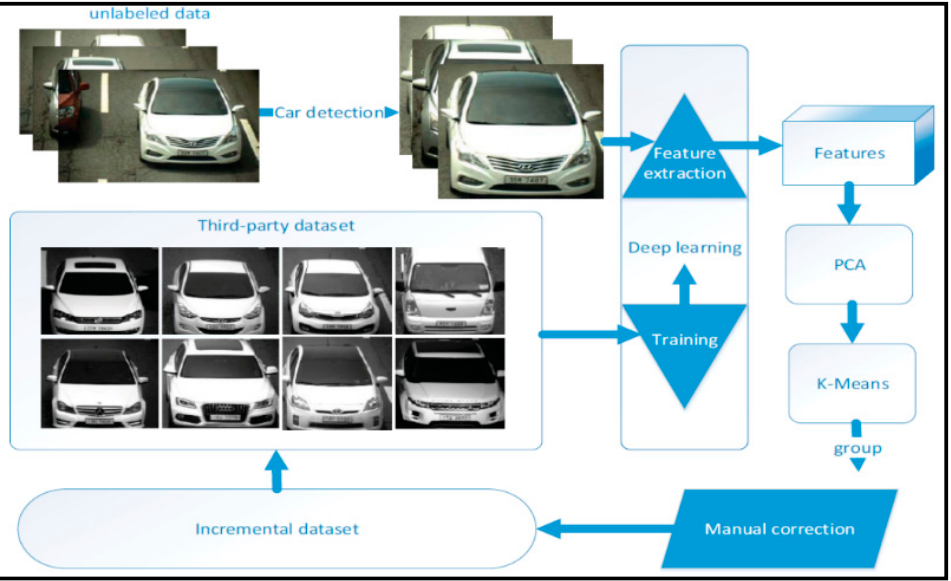
Figure 5. Framework for the proposed car detection and clustering method.